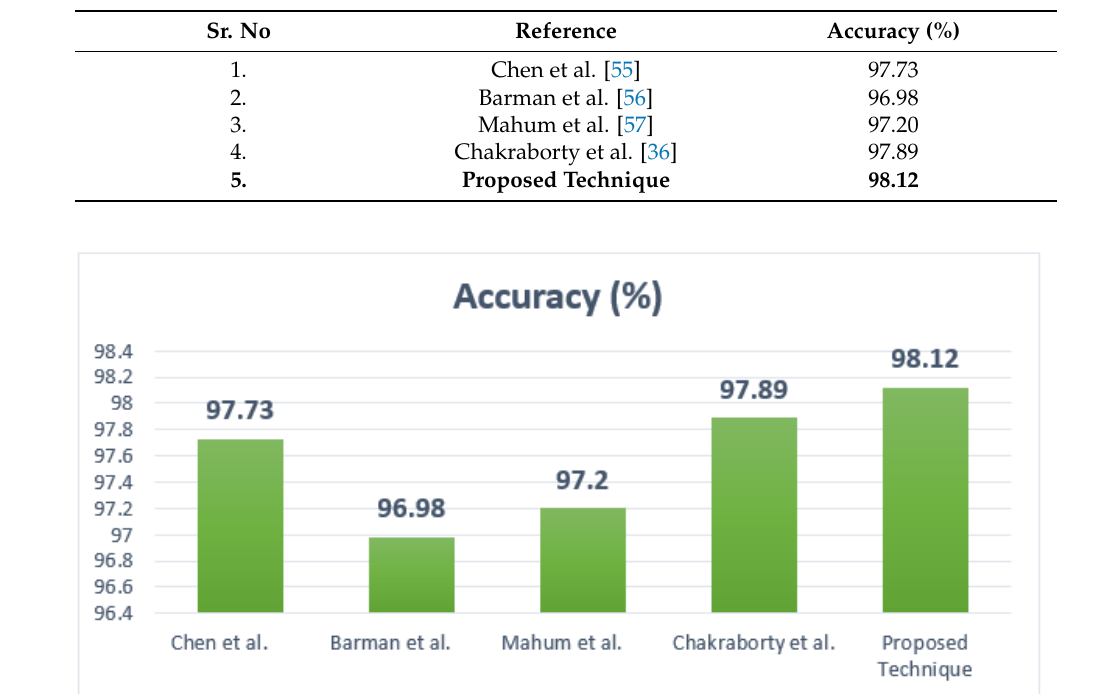
Figure 10. A comparison with the latest works developed by Chen et al. [55], Barman et al. [56], Mahum et al. [57] and Chakraborty et al.